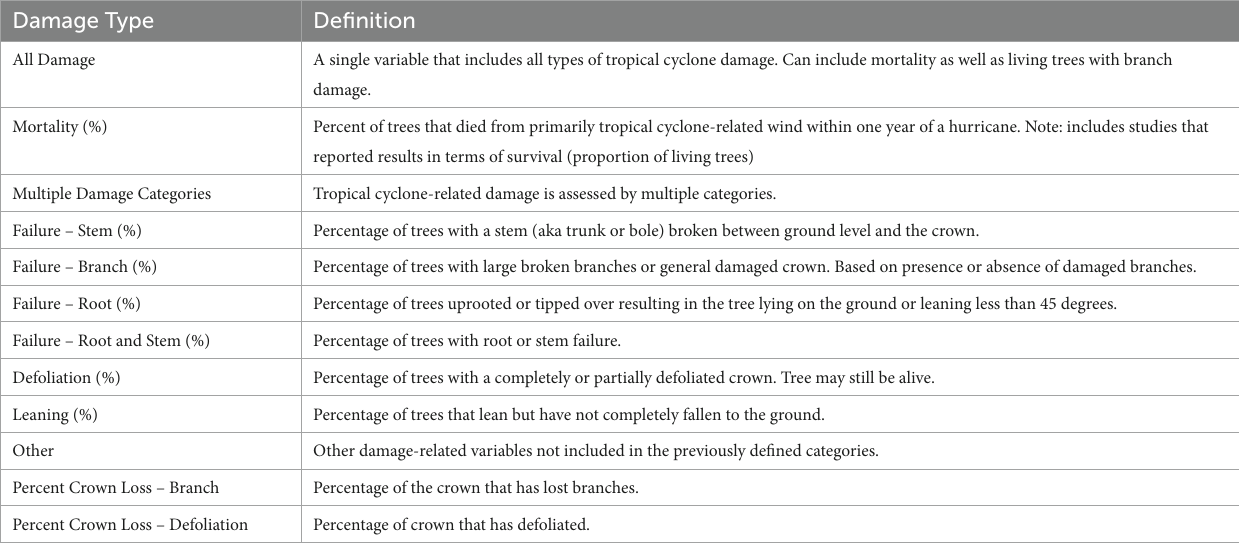
TABLE 1 Types and definitions of tropical cyclone tree damage identified in the literature